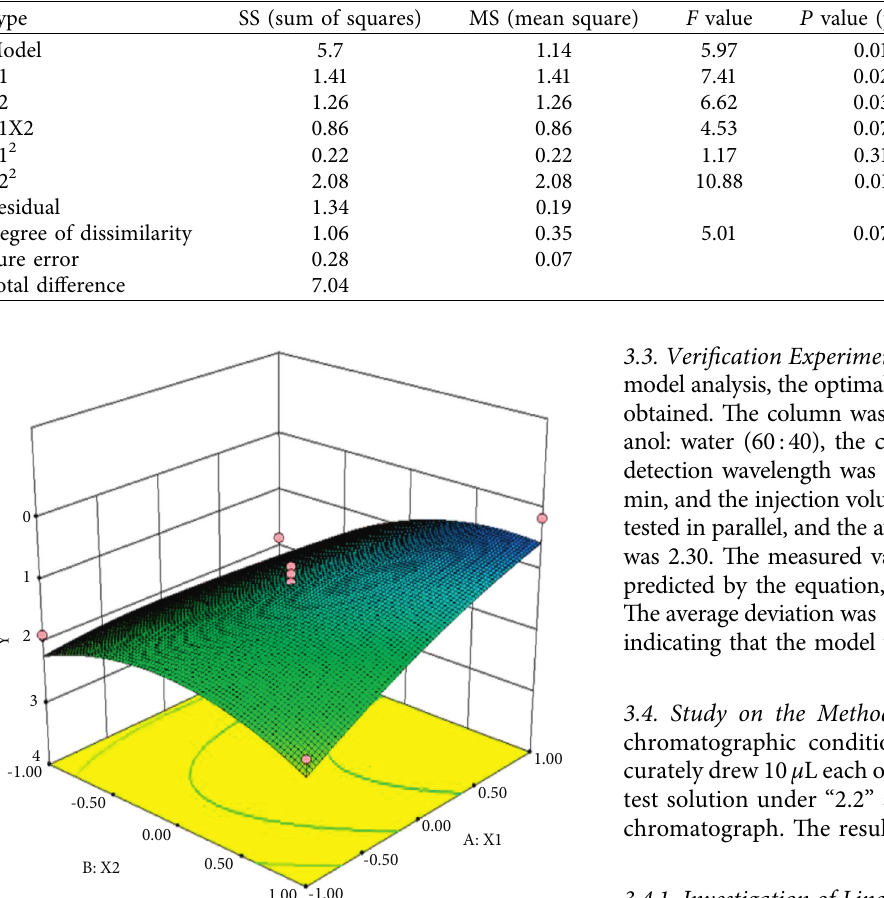
Figure 3: Response surface diagram of the effect of methanol ratio and column temperature on